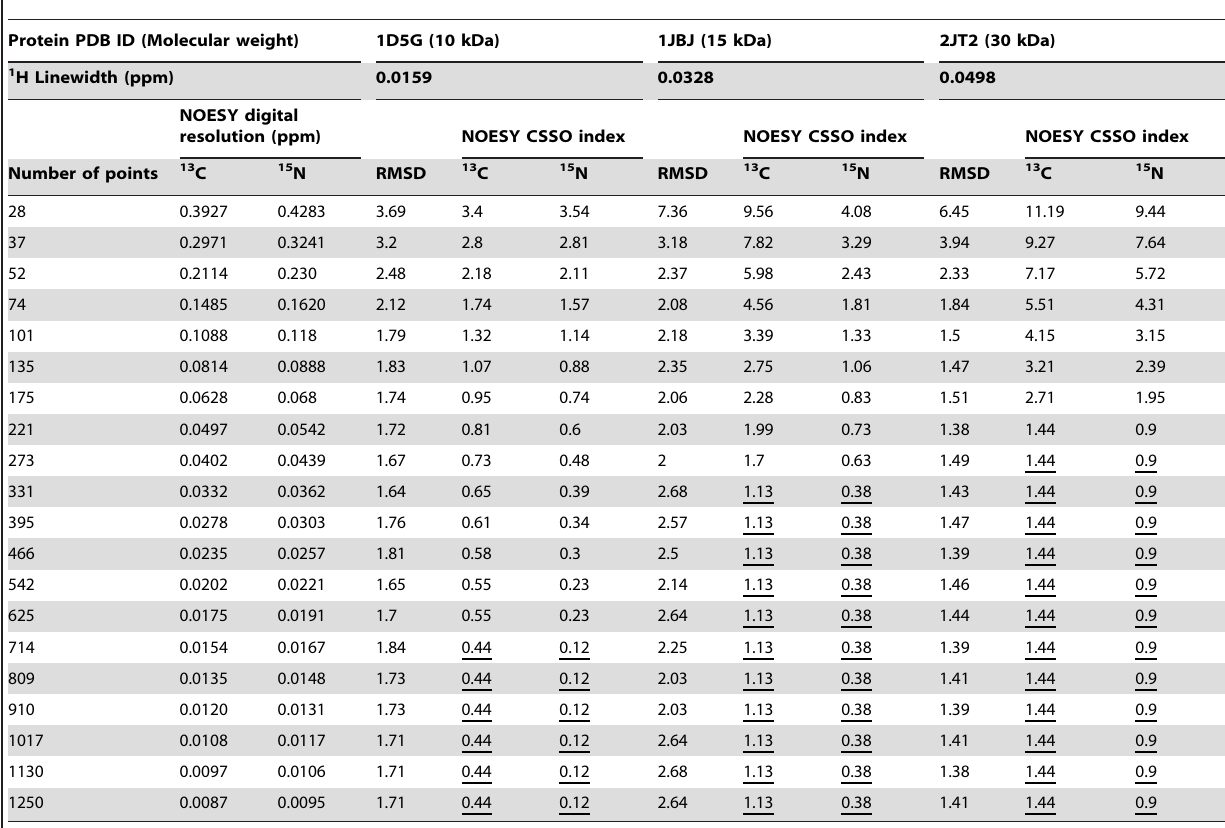
Table 1. The 3D NOESY digital resolutions, RMSD values, and 13 C- and 15 N-resolved NOESY CSSO indices, for three calculated protein structures of different molecular sizes, are listed.